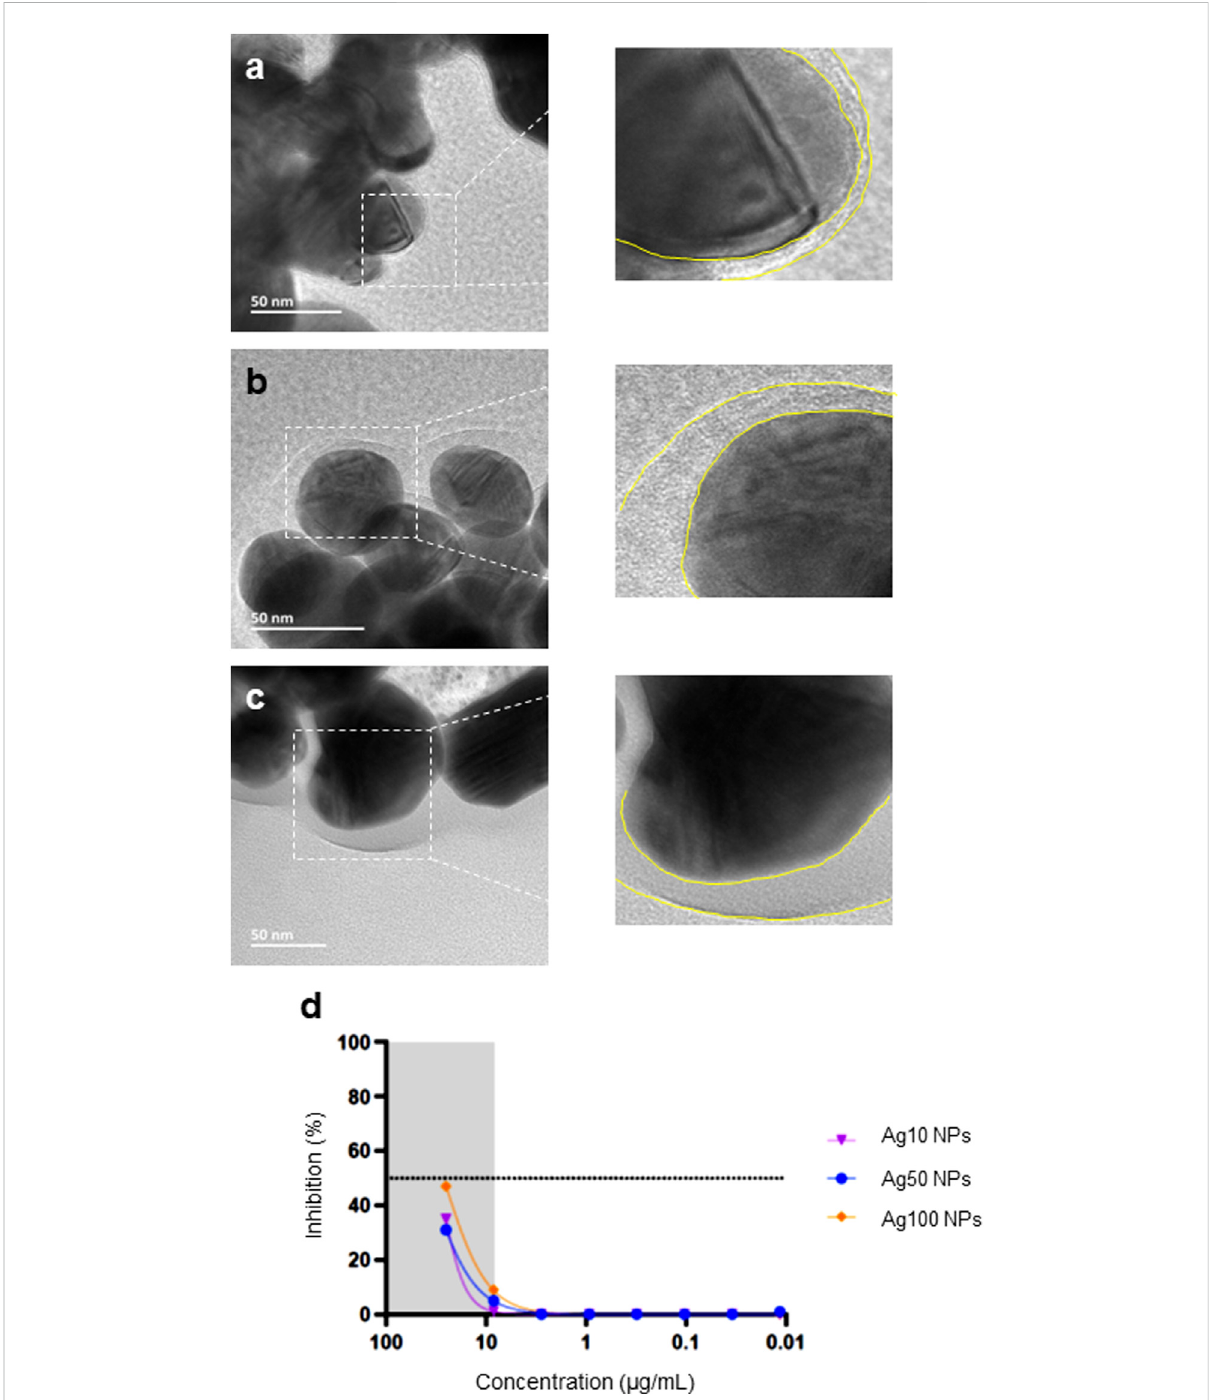
FIGURE 4 Bio-corona formation on Ag NPs. Ag NPs were incubated in 10% FBS in MilliQ ® water for 1 h at 37 ° C at 100 μ g/ml and FBS-Ag NP complexes were isolated and washed once by centrifugation. The bio-corona on the Ag NPs surfaces was visualized by HR-TEM: (A) Ag-B (Sigma), (B) Ag50 (NanoComposix),and (C) Ag100(NanoComposix).NotethatalltheAgNPstestedwerebare(uncoated)(seemaintext).Theyellowdottedlinesinthe magni fi ed images serve to show the thickness of the bio-corona. (D) Pseudovirus neutralization assay using bare Ag NPs of varying particle diameters (NanoComposix). The virus was pre-incubated with the Ag NPs for 1